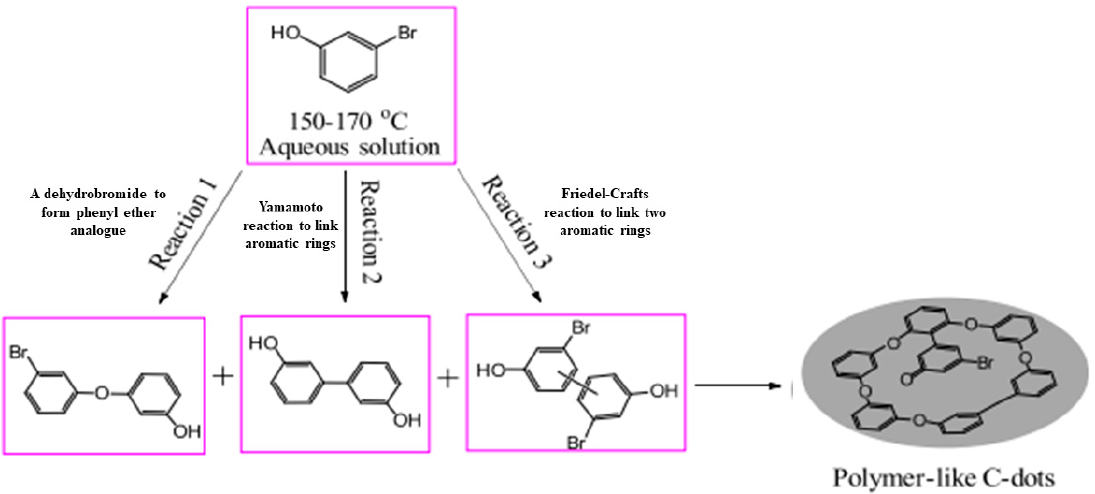
Figure 5. Proposed possible mechanisms for the formation CDs using 3–bromophenol. Reproduced with copyright permission of Elsevier [206].